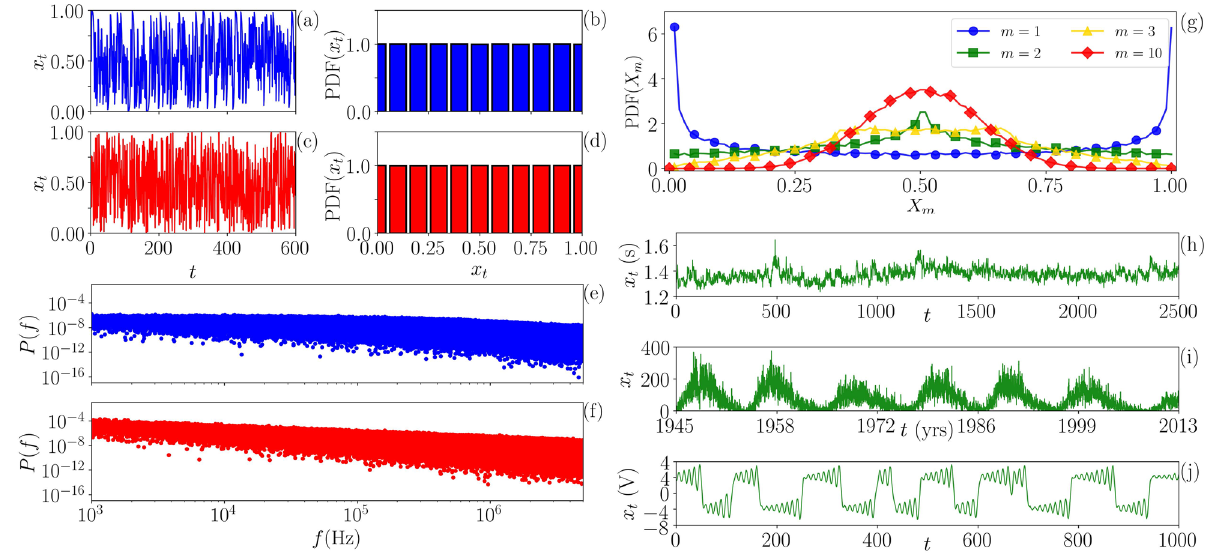
Figure 1. Examples of time series analyzed, their probability density functions (PDFs) and power spectral densities (PSDs). ( a , b ) Time series generated by iteration of the β x map [Eq. (6) with β = 2 ] and its PDF. ( c , d